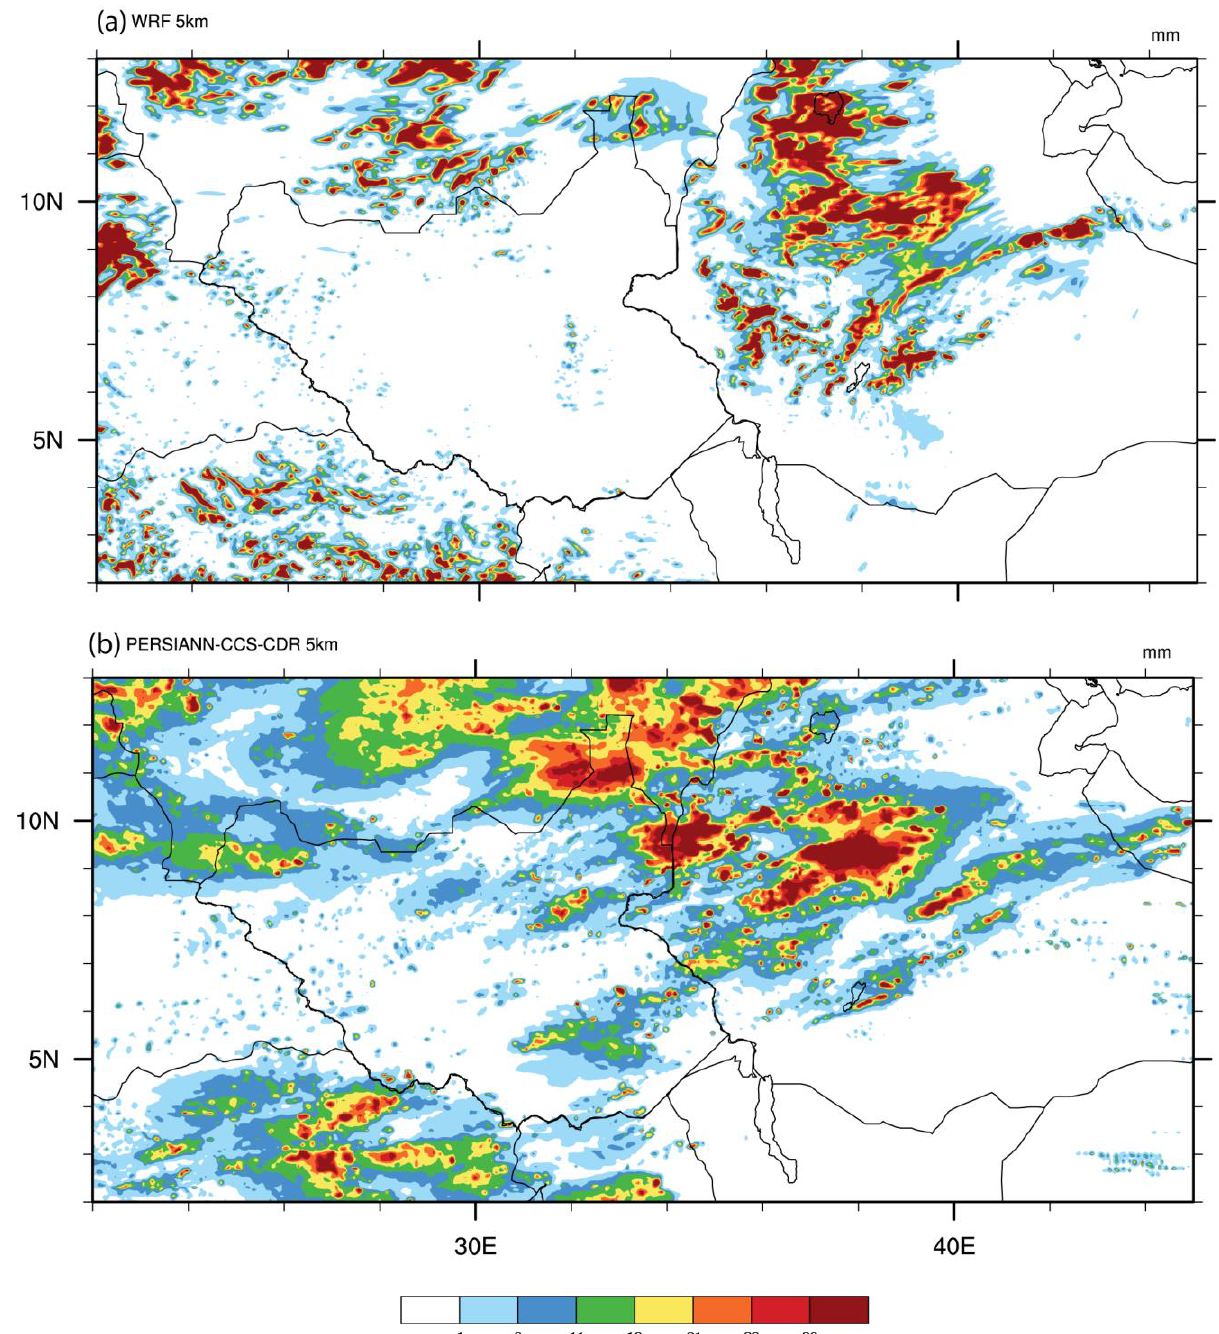
Figure 9. Distribution of simulated and observed precipitation (mm/day) on 27 August 2020 over East Africa. ( a ) WRF; ( b ) PERSIANN-CCS-CDR. East Africa. ( a ) WRF; ( b )